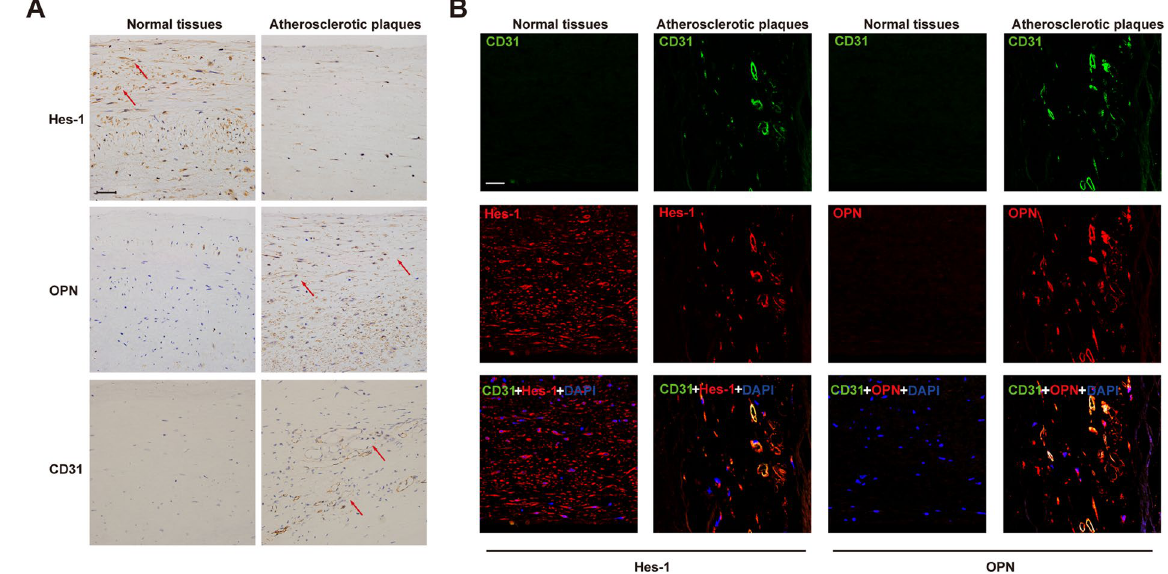
Figure 2. Hes-1 was downregulated in neovessels of atherosclerotic plaques and OPN was upregulated in ECs of neovessels in atherosclerotic plaques. ( A ) Immunohistochemical staining of Hes-1, OPN, and CD31 in normal arterial intima tissues and atherosclerotic plaques. Representative photomicrographs at × 40 magnification of stained tissues sections demonstrating greater staining for Hes-1 and OPN in arterial intima tissues. Bar: 50 μ m. ( B ) Colocalization of CD31 and Hes-1 or OPN in normal arterial intima tissues and atherosclerotic plaques. Merged images in which the expression of CD31 is shown in green and the expression of Hes-1 and OPN are shown in red. The yellow fluorescence represents the coexpression of CD31 and Hes-1/ OPN in endothelial cells of neovessels in atherosclerotic plaques. Note that expression was limited to atherosclerotic plaques. Normal arterial intima typically lacked signals of CD31 and neovessels. Nuclei are counterstained with DAPI (blue). Original magnification 40x; Bar: 50 μ m.